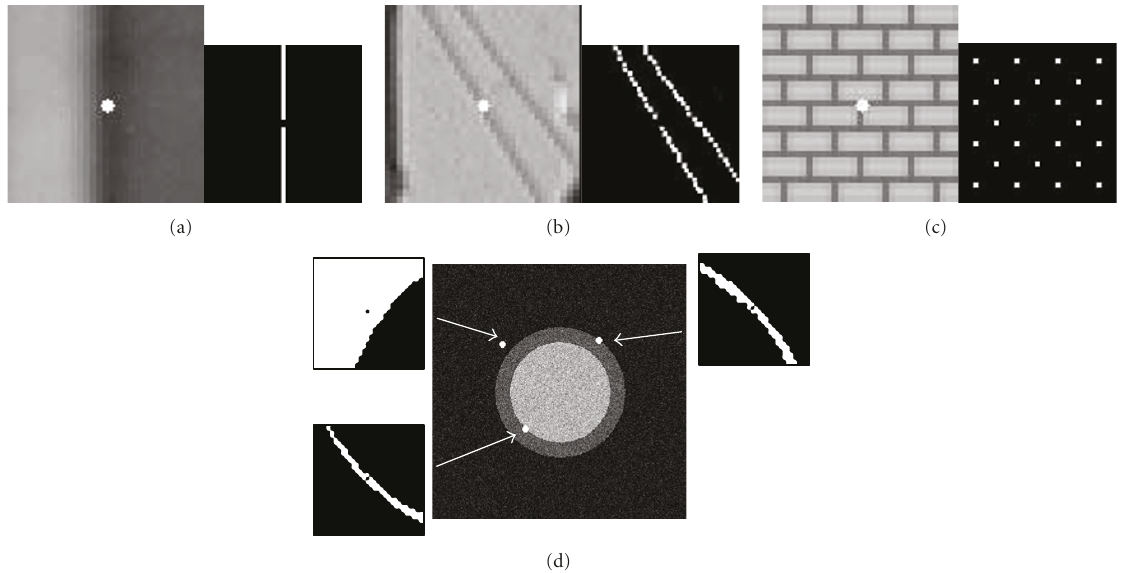
Figure 1: Illustrations of the weight distributions of the adaptive neighborhood system for the proposed SA prior model. The sizes of neighborhoods N and n are 31 × 31 and 7 × 7, respectively. (a) The weight factors w bj are distributed in the direction of the straight edge line when the centered pixel j is in a straight alike configuration. (b) The weight factors w bj are distributed in the direction of the edge line when the centered pixel j is in an oblique edge. (c) The weight factors w bj are adaptively distributed along the pixels in the same structures when the centered pixel j is in some special structure. (d) The weight factor distributions for the three centered pixels in the two edge regions and the background region, respectively, are